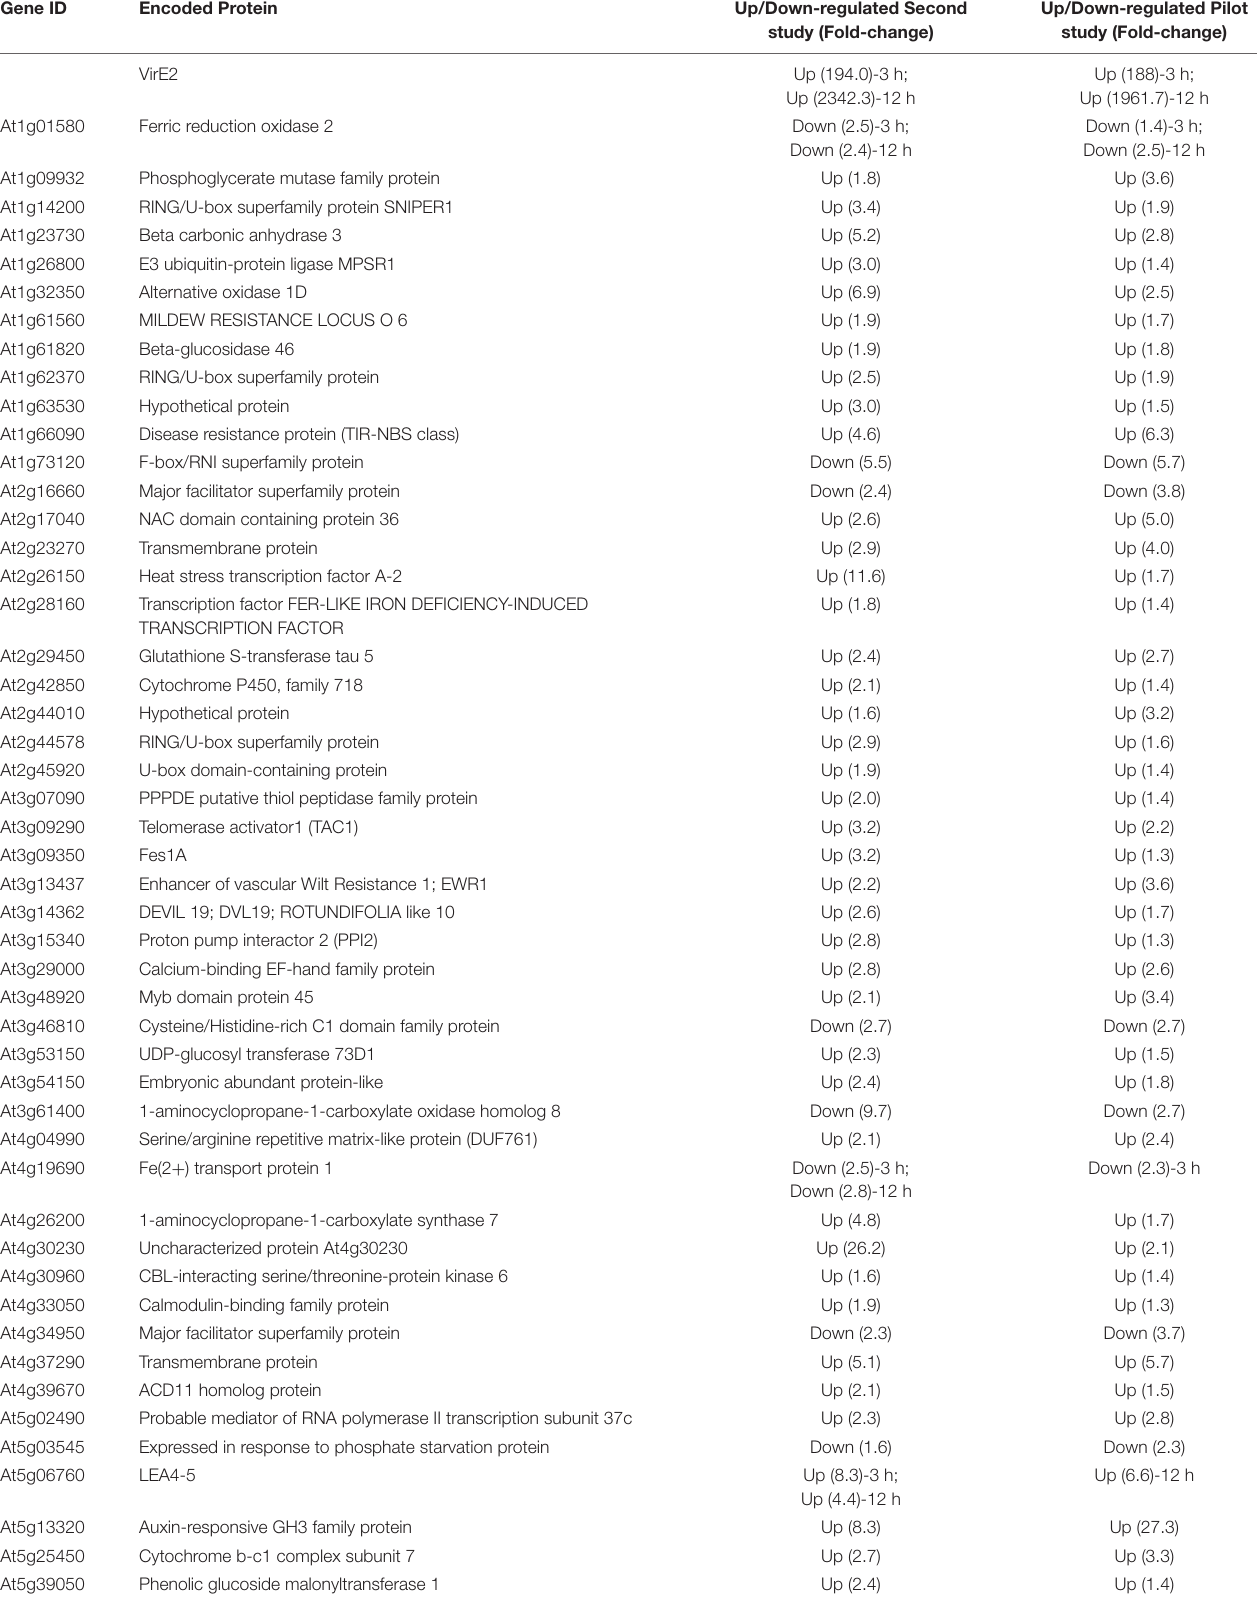
TABLE 1 | VirE2 differentially expressed genes in both RNA-seq studies. Gene ID Encoded Protein Up/Down-regulated Second